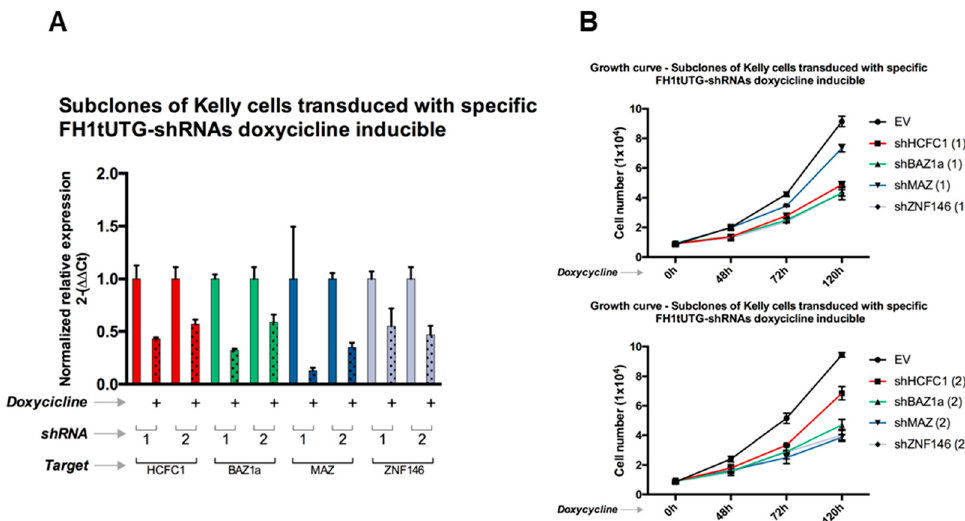
Figure 6. ( A ) Growth curves of Kelly cells stably expressing shRNA for genes HCFC1, BAZ1A, MAZ, and ZNF146, the silencing of which was induced (+) by doxycycline (2 ug/mL) at 0 h, 48 h, 72 h, and 120 h. EV = empty vector. Two different shRNAs were designed for each gene, and the results are shown separately in the top and bottom panels. ( B ) Normalized relative expression for the target gene of each shRNA construct. Error bars indicate the standard error (RT-qPCR was performed in triplicates).